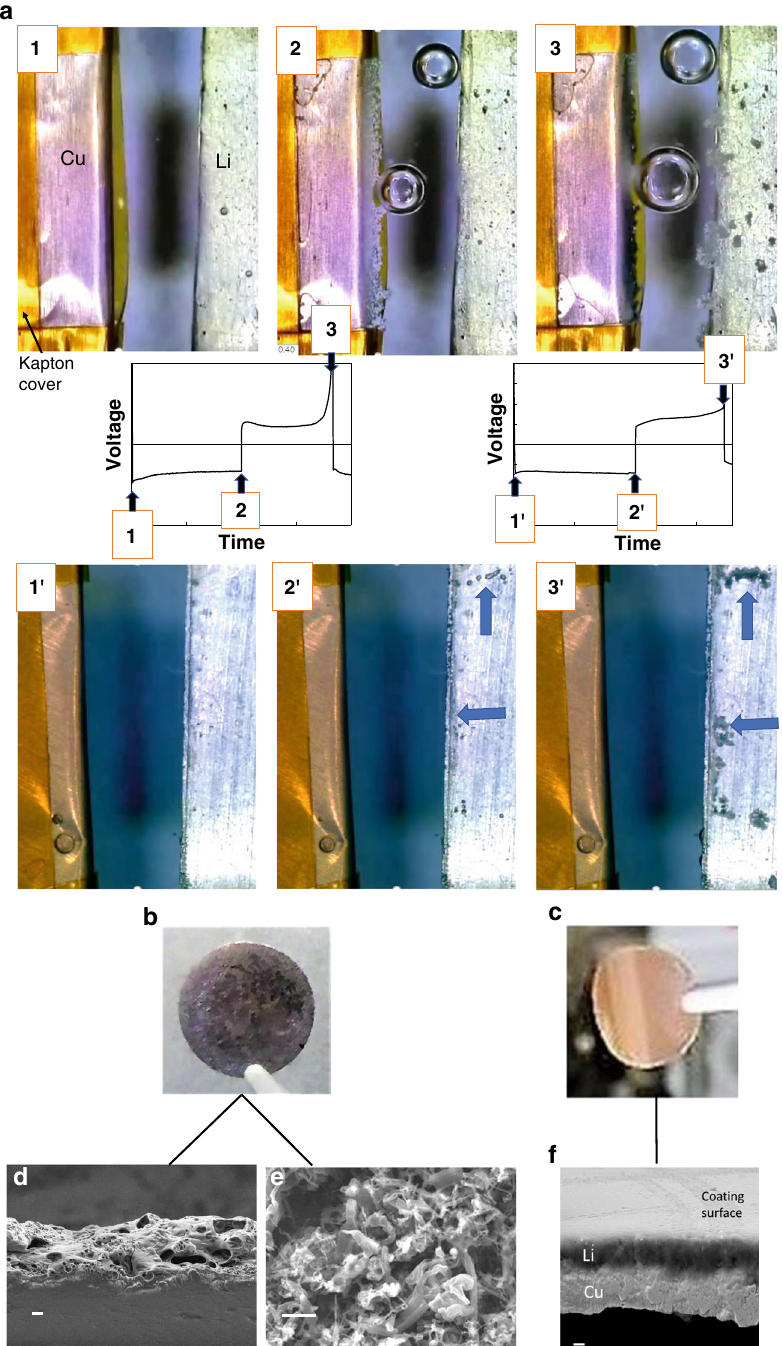
Fig. 4 Operando and postmortem analyses on Li plating. a Operando observation of Li-plating and stripping in a glass cell using (frames 1 – 3) a pristine Cu electrode and (frames 1 ′ – 3 ′ ) a SPEEK-Li/POSS-coated Cu electrode as anodes and the Li metal foil as a cathode with a carbonate-based electrolyte; the voltage- vs.-time plots indicate the moments when the snapshots are taken; optical images showing the Li-plating morphology for b a pristine Cu electrode and c a SPEEK- Li/POSS-coated Cu electrode which have been subjected to two and half galvanostatic Li plating – stripping cycles in coin cells (current density = 1mAcm − 2 and Li plating capacity = 2mAhcm − 2 ); d SEM micrograph showing the cross-section of ( b ), scale bar: 10 μ m; e SEM micrograph showing the surface morphology of ( b ) after being washed with organic solvent, scale bar: 5 μ m; f SEM micrograph showing the cross-section and surface morphology of ( c ), scale bar: 5 μ